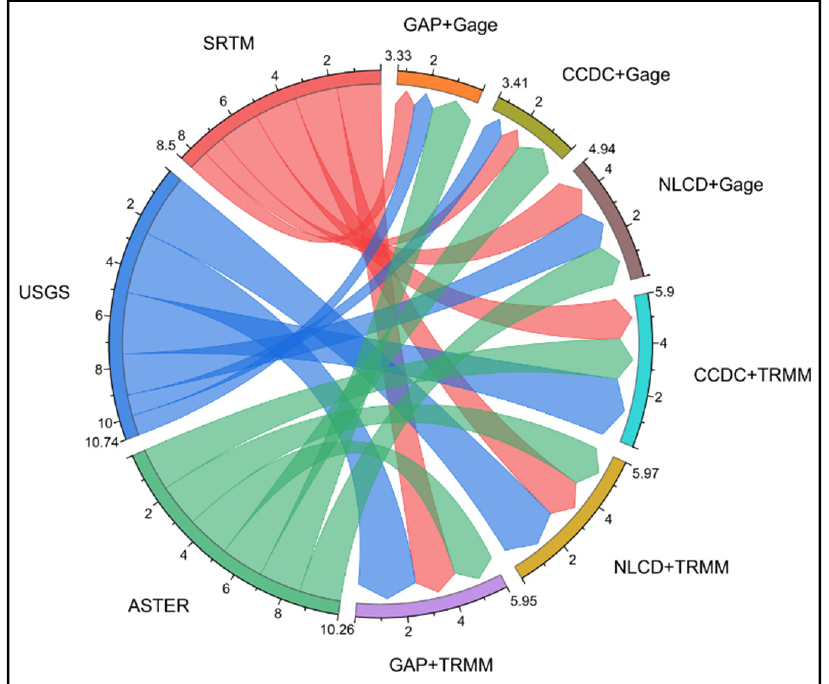
Figure 17. Plot showing the efficiency of combinations irrespective of climatic and topographical regions for NSE > 0.75.